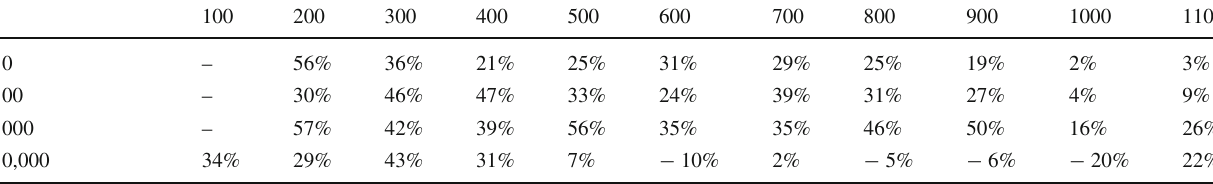
MLM matching Decay length (cm)